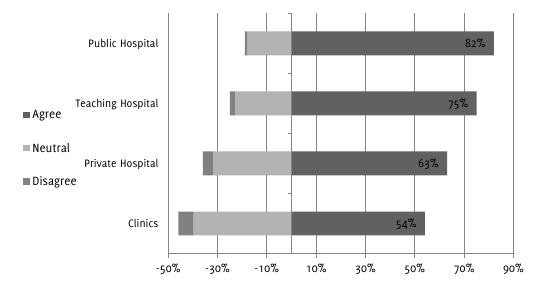
Note: Percentages from total patient population, N=262.